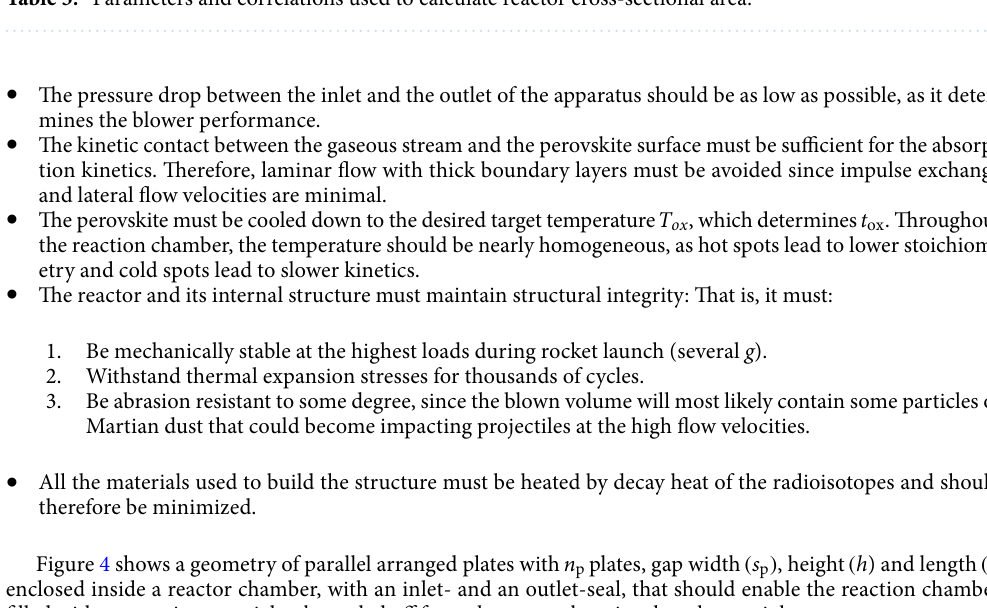
Table 3. Parameters and correlations used to calculate reactor cross-sectional area.